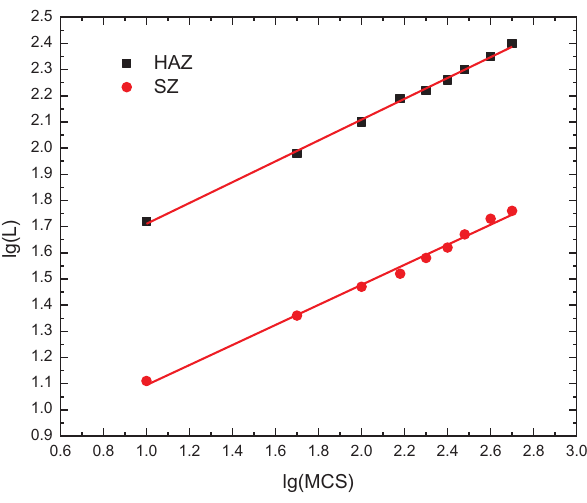
Figure 3: Relation between MCS and L in SZ and